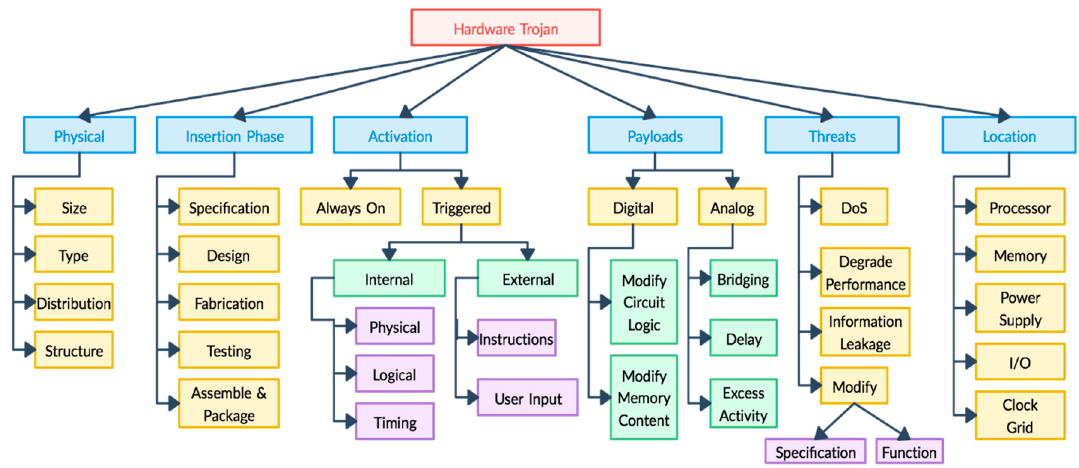
Figure 2. Taxonomy of hardware Trojan. DoS: Denial of Service; I/O: Input/Output.